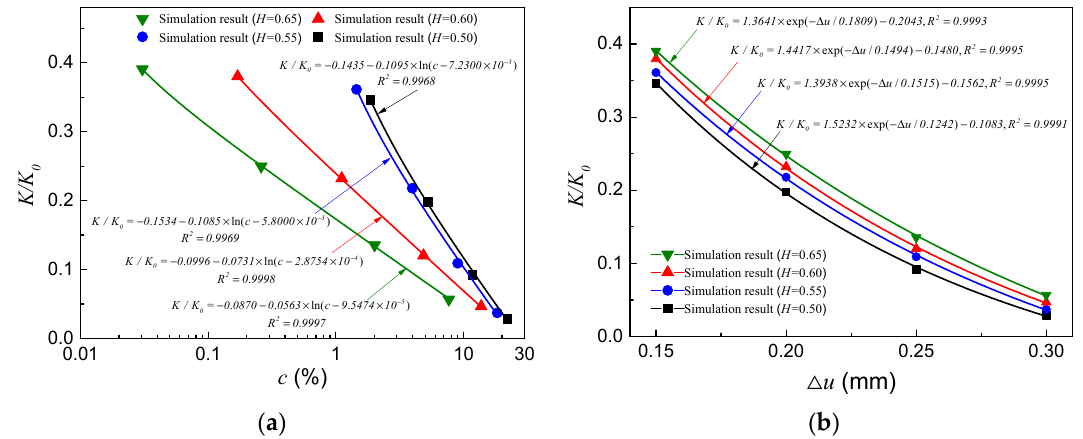
Figure 8. Relationships between relative permeability ( K/K 0 ) and c or Δ u for fractures with different H : ( a ) K/K 0 versus c ; ( b ) K/K 0 versus Δ u .